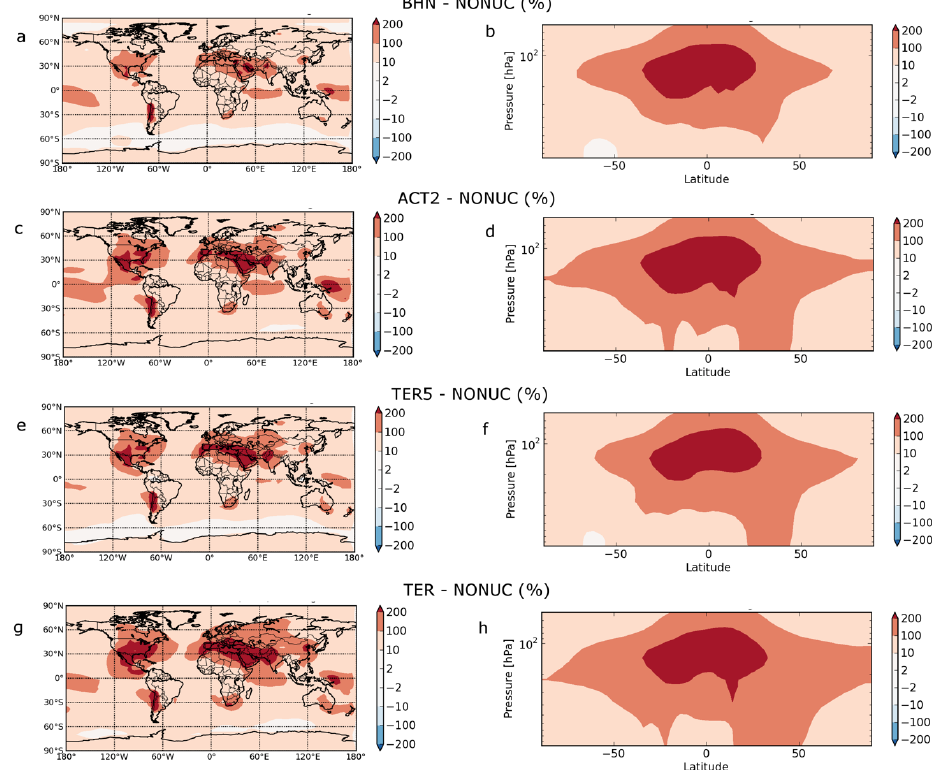
Figure 3. Global cloud condensation nuclei concentration at S = 0.2% (CCN(0.2%)) percent change surface and zonal plots. Color contours in all panels represent the percent change in number concentration between the various nucleation simulations and the simulation with nucleation off: (a, b) binary; (c, d) Activation ( A = 2 × 10 − 6 ); (e, f) Ternary (10 − 5 factor); (g, h) Ternary.